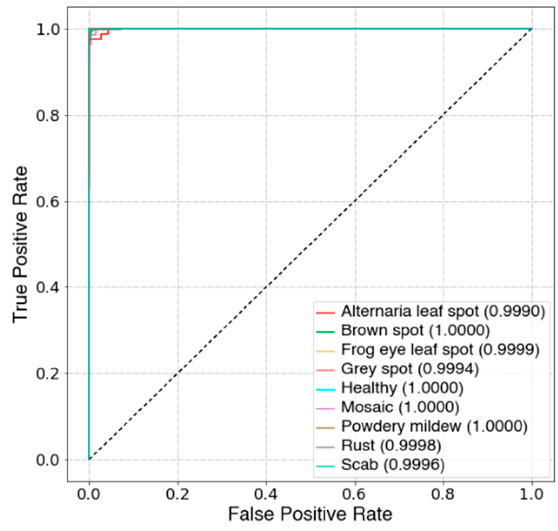
Figure 12. ROC curves of different categories.